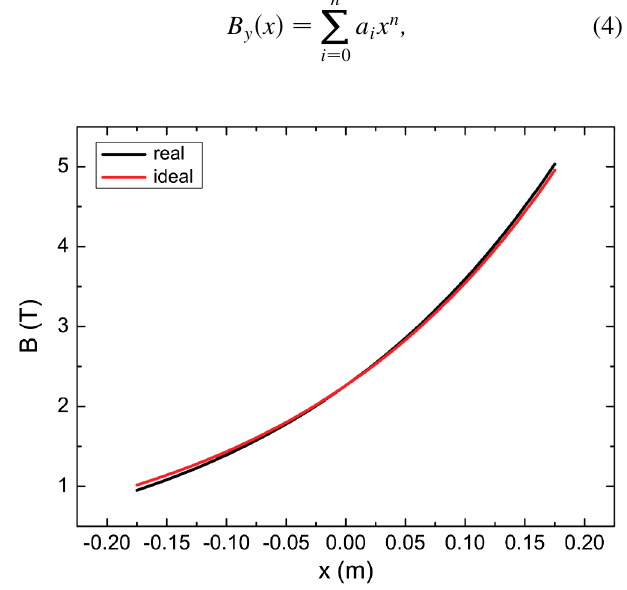
FIG. 17. A typical magnetic field using the scaling law in black, with the red curve highlighting the part experienced by the